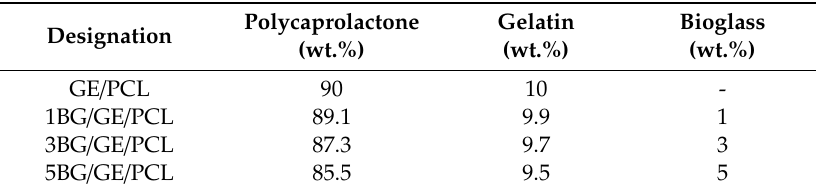
Table 1. Designation and specification of di ff erent